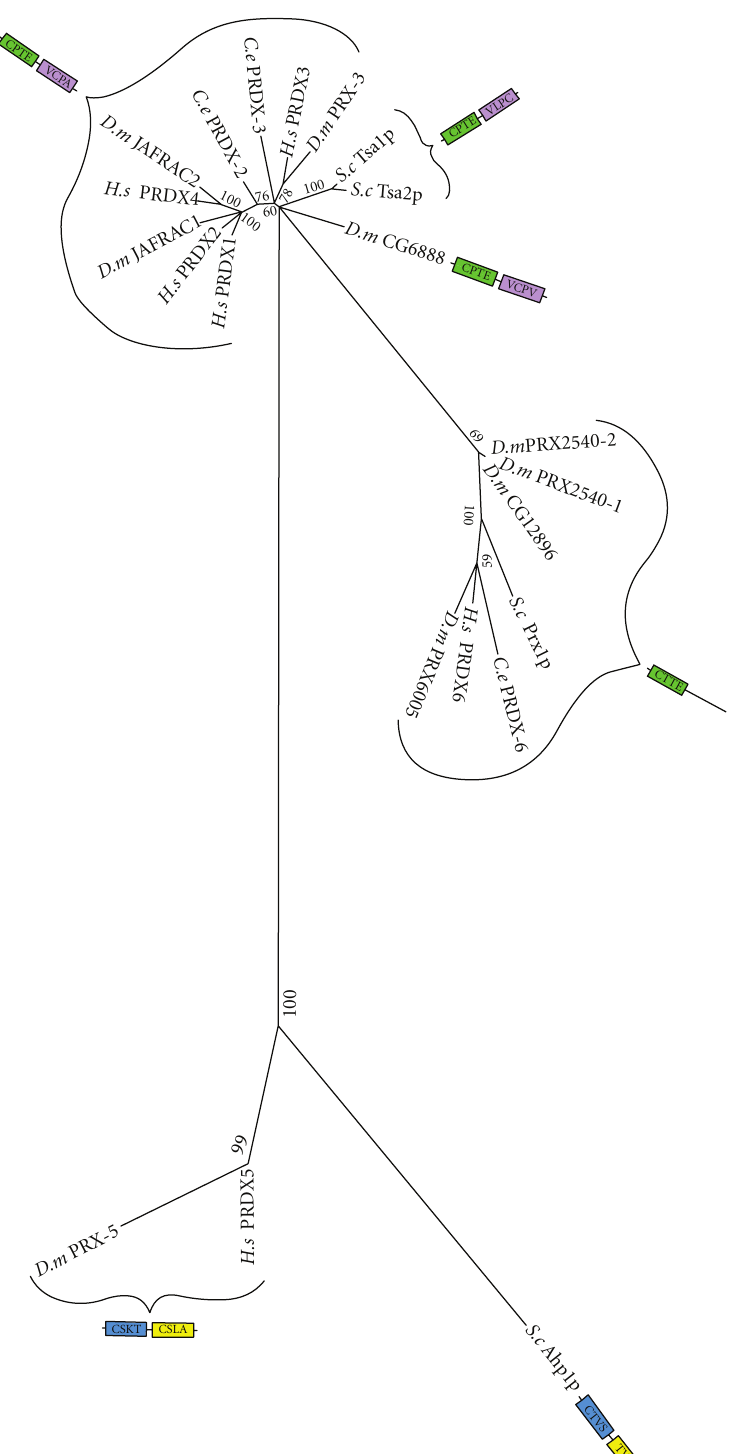
Figure 12: Maximum likelihood majority-rule bootstrap consensus tree of peroxiredoxin (PRDX) proteins.“Typical” 2-Cys PRDX is shown in green and purple; “Atypical” 2-Cys in blue and yellow; and 1-Cys in green. Active site cysteine regions highlighted in the same colour are those that aligned in the MSA. See Figure 5 for details of how the sequences were identified and processed as well as how the phylogenetic analysis was carried